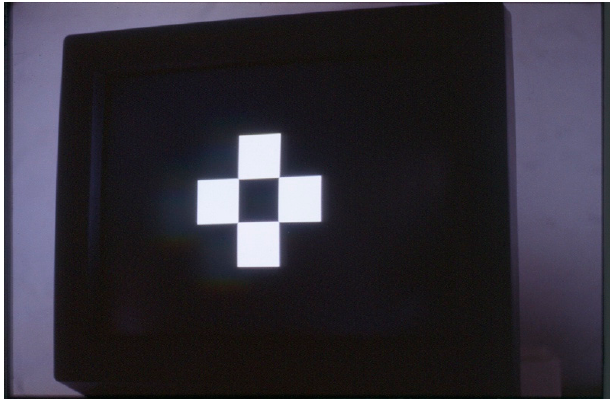
Figure 6. Fragment 1984–5, still from the exhibition ‘Duality and Co-existence’ Exhibiting Space, London, 1985. Photo Ernest Edmonds, © Ernest Edmonds.